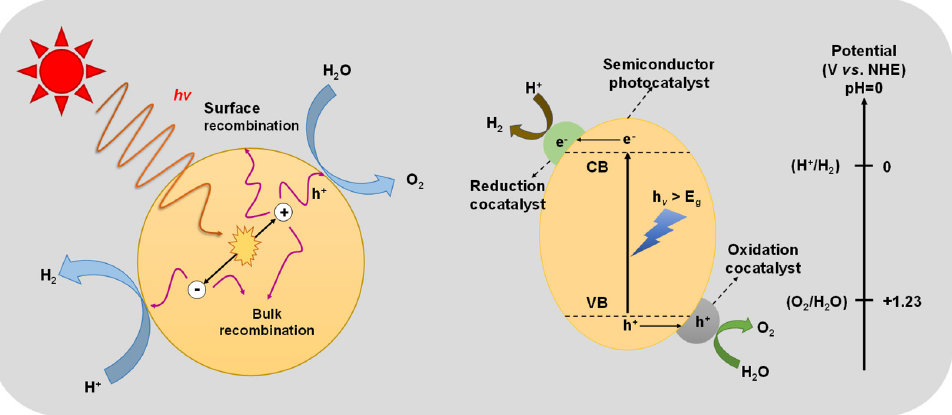
Figure 1. Schematic descriptions for photocatalytic overall water splitting.